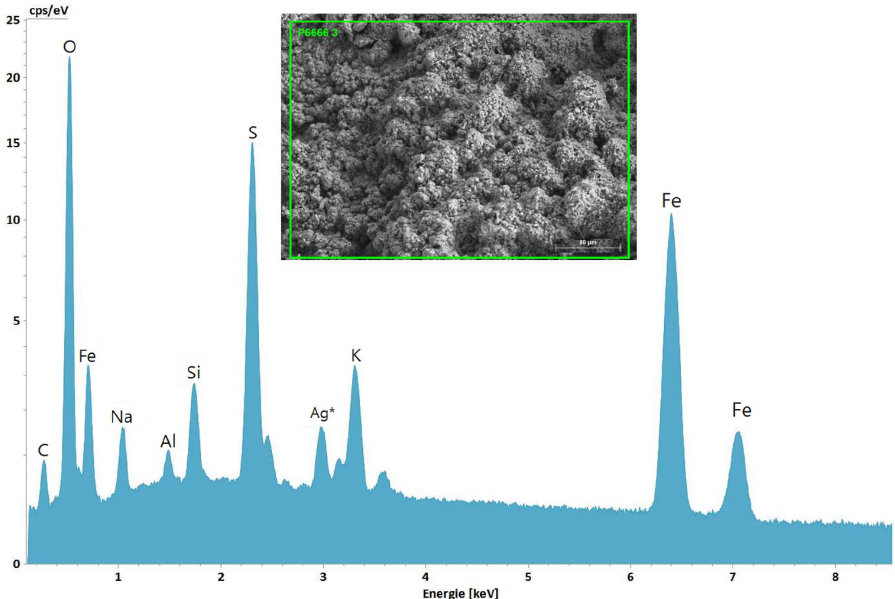
Figure 10. SEM image with selected area for EDS analysis (inset) and the corresponding EDS spec- trum acquired from a sample of Stefføya. Jarosite, natrojarosite, aluminosilicates and silicates are implied from the elements detected.